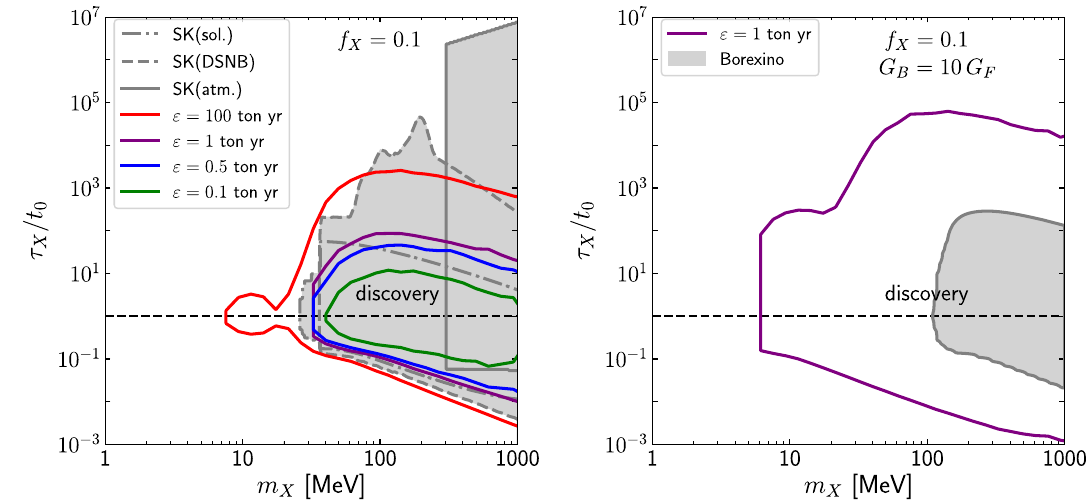
Fig. 6 The distribution of maximum likelihood parameters σ n , m χ under the DM hypothesis when they originate from DR with various combinationsof (τ X , m X ) informofSMneutrinos(leftpanel)andbary- onic neutrinos (right panel) instead. The gray points as labeled show